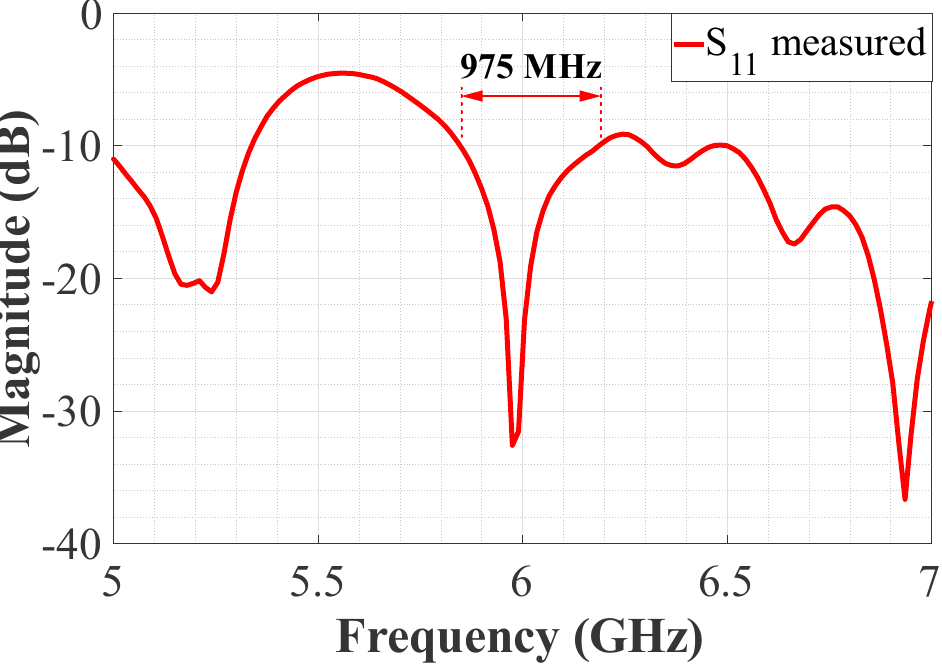
Figure 9. Linear phased array, ( a ) antenna elements configuration, and ( b ) the fabricated prototype of the complete system with power values of approximately 15 dBm, and phase shift values of (0 ° ,